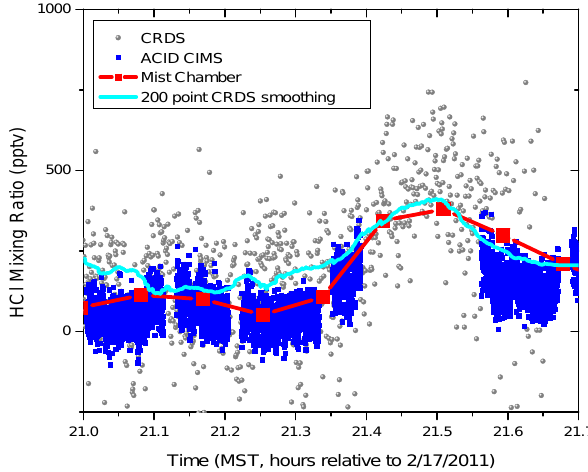
Fig. 10. HCl concentration values recorded by the CRDS, ACID CIMS, and mist chamber instruments during the NACHTT campaign. The time is Mountain Standard Time.